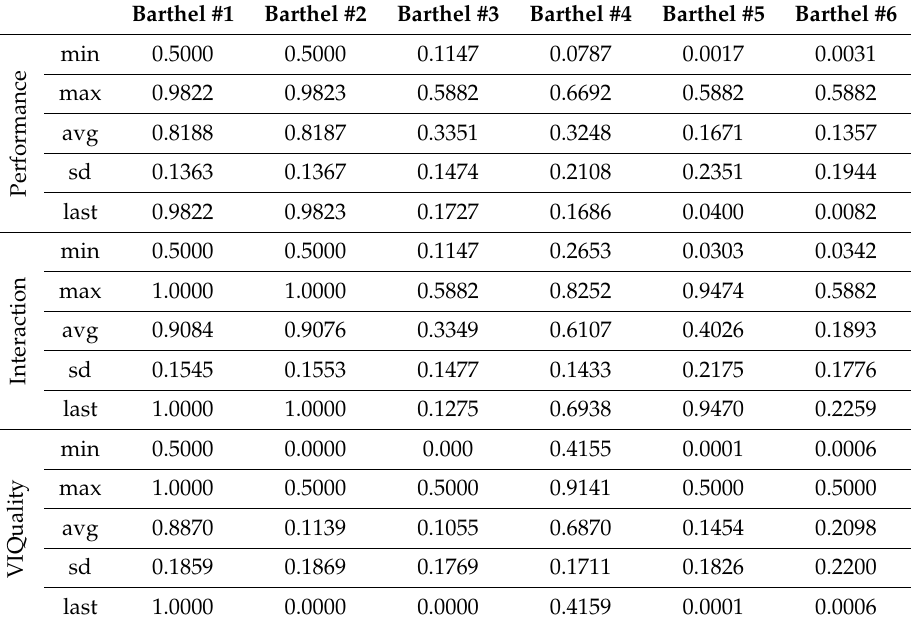
Table 3. Barthel test results associated to the tests in Table 2 (see text for